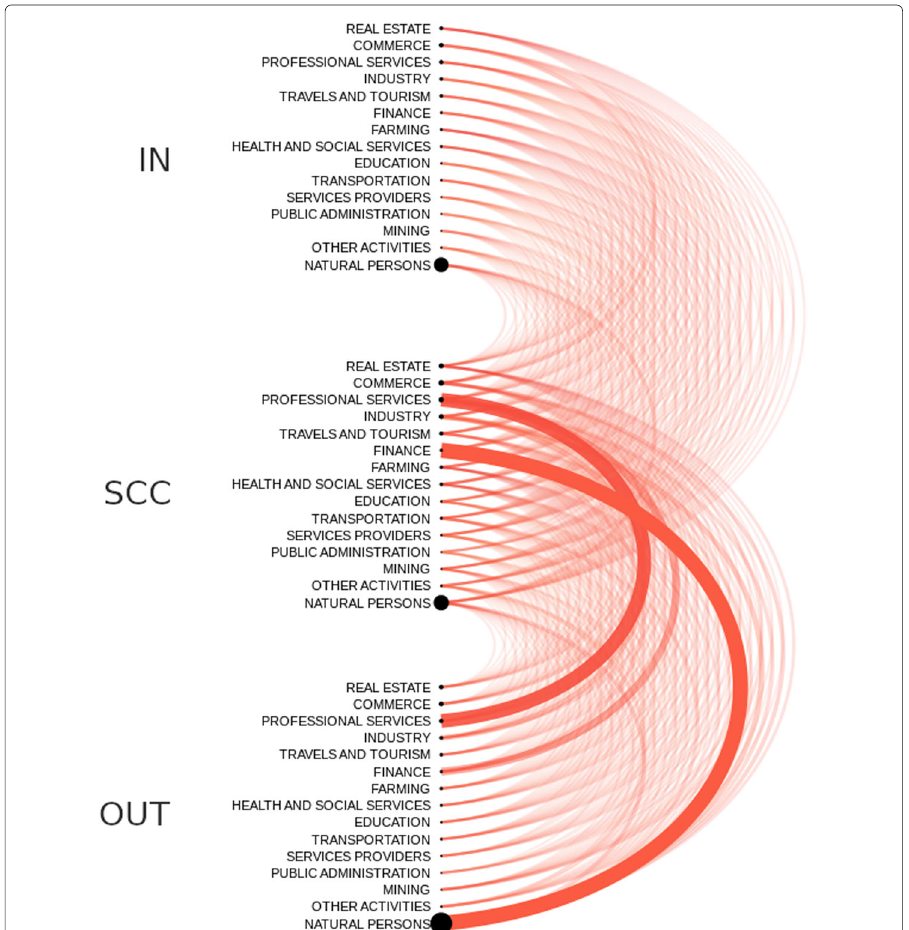
Fig. 16 Wire transfers between components: Total amount of wire transfers between natural persons and legal entities belonging to different components. Legal entities are classified separately by their business sectors. Directions should be read from top to